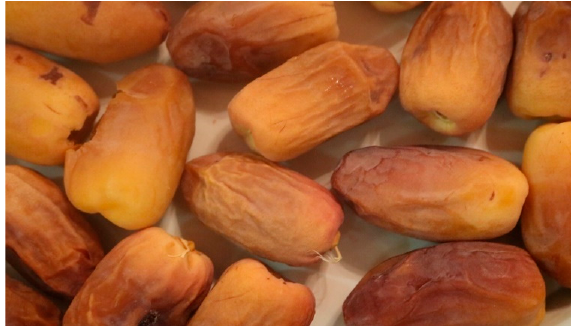
Figure 26. Sample of NbotAli dates.